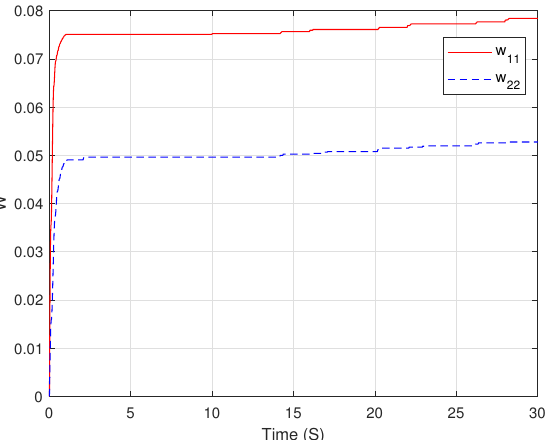
Figure 6. The adaptive parameters for the adaptive robust control term (35).